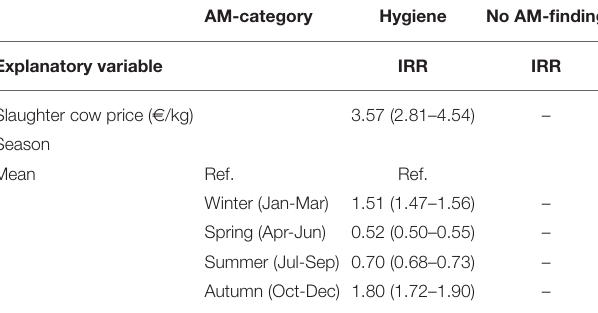
TABLE 4 | Results of multivariable analyses of AM-findings amongst slaughtered cattle from dairy herds between January 1, 2015 and September 30, 2018, in incidence ratios (IRR) and 95% confidence intervals. Only associations with a p-value < 0.05 that met the relevance criteria (IRR ≤ 0.8 or ≥ 1.25) are shown (N =